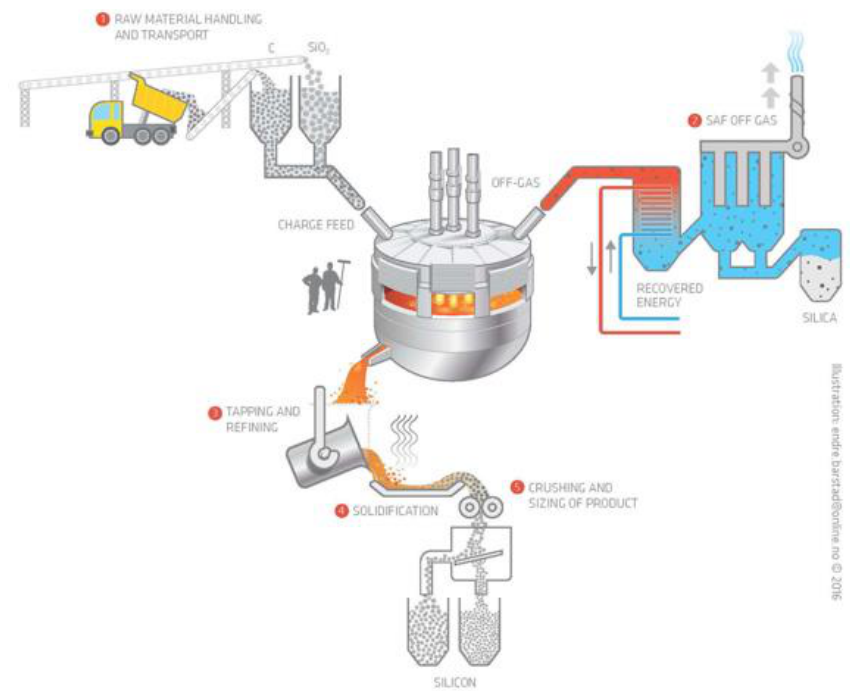
Figure 12. High silicon alloy production process and its primary emission sources [36] Bubble burst is active in all liquid metal reactors, like converters or ladles. In combination with gas or powder injection, it is also essential in a liquid bath smelter.